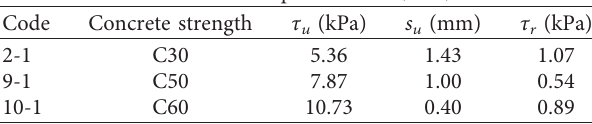
Figure 10: τ − s curves of Group B-3 and B-4. (a) τ − s curves of Group B-3. (b) τ − s curves of Group B-4. Table 9: Test results of specimens 2-1, 9-1, and